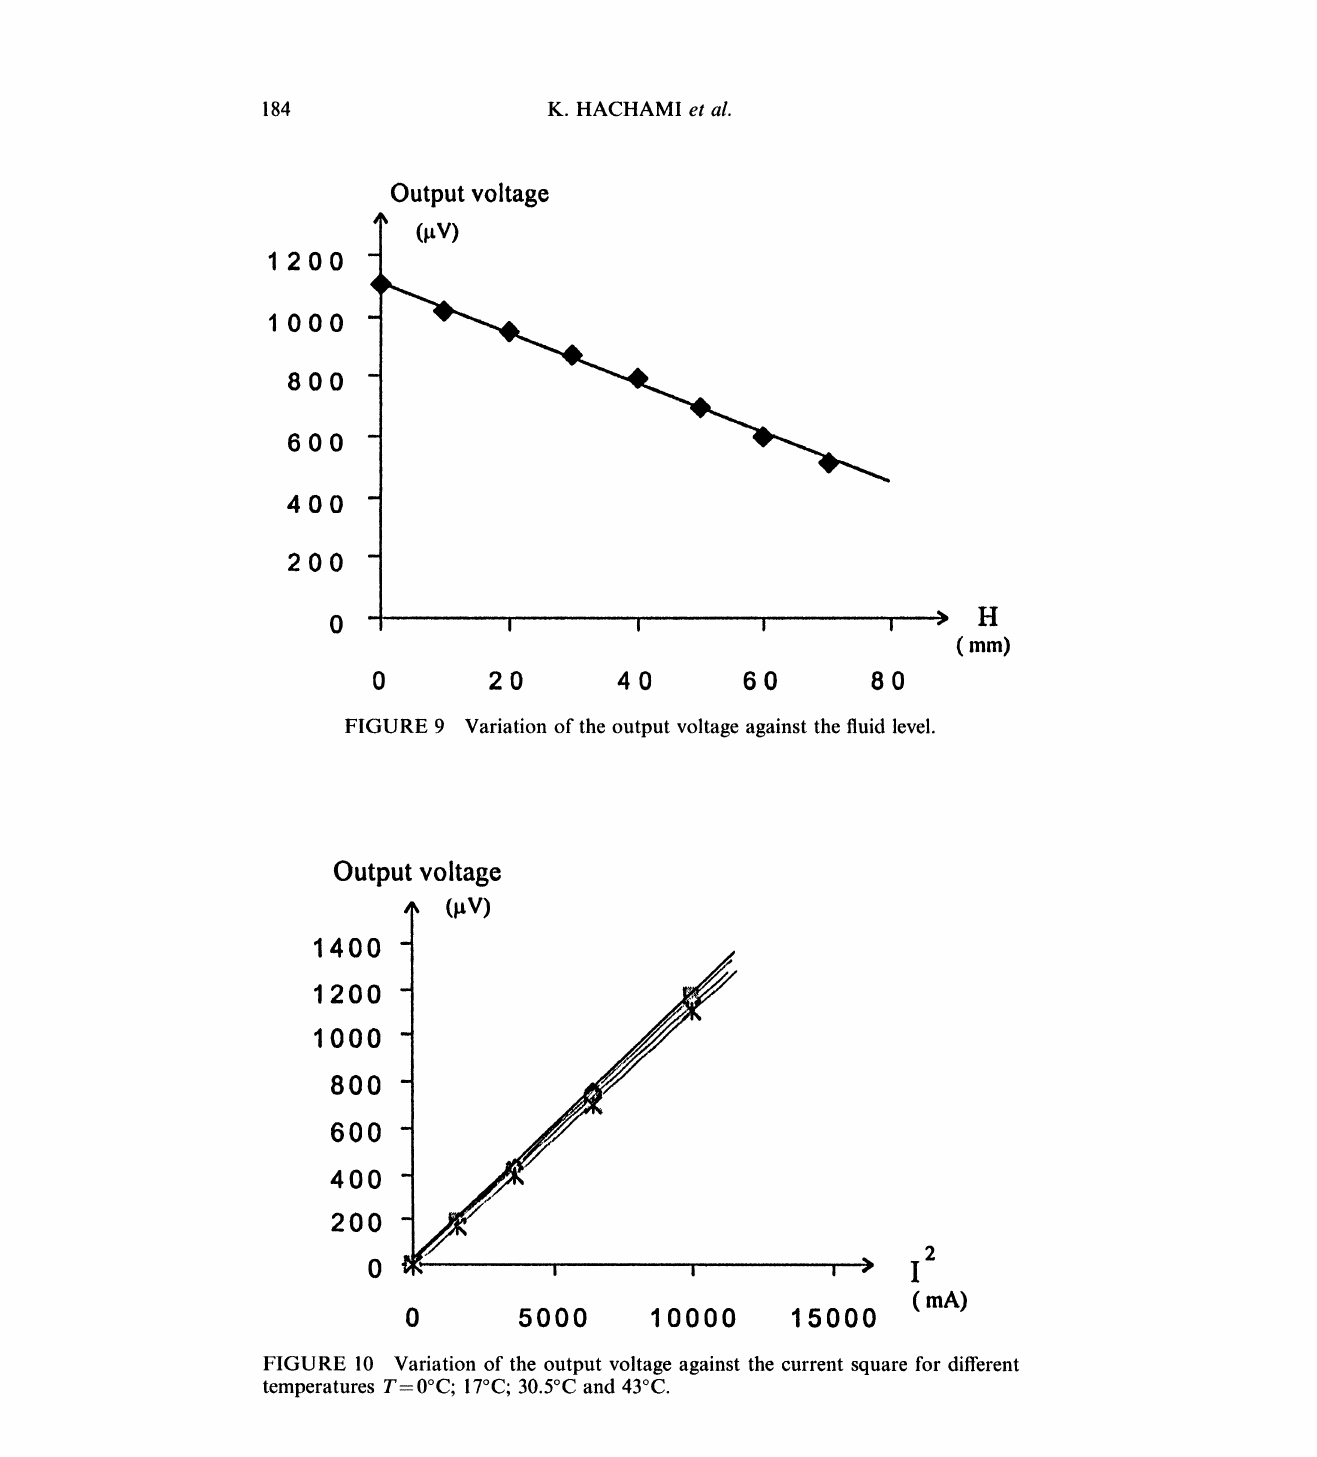
FIGURE 10 Variation of the output voltage against the current square for different temperatures T=0C; 17C; 30.5C and